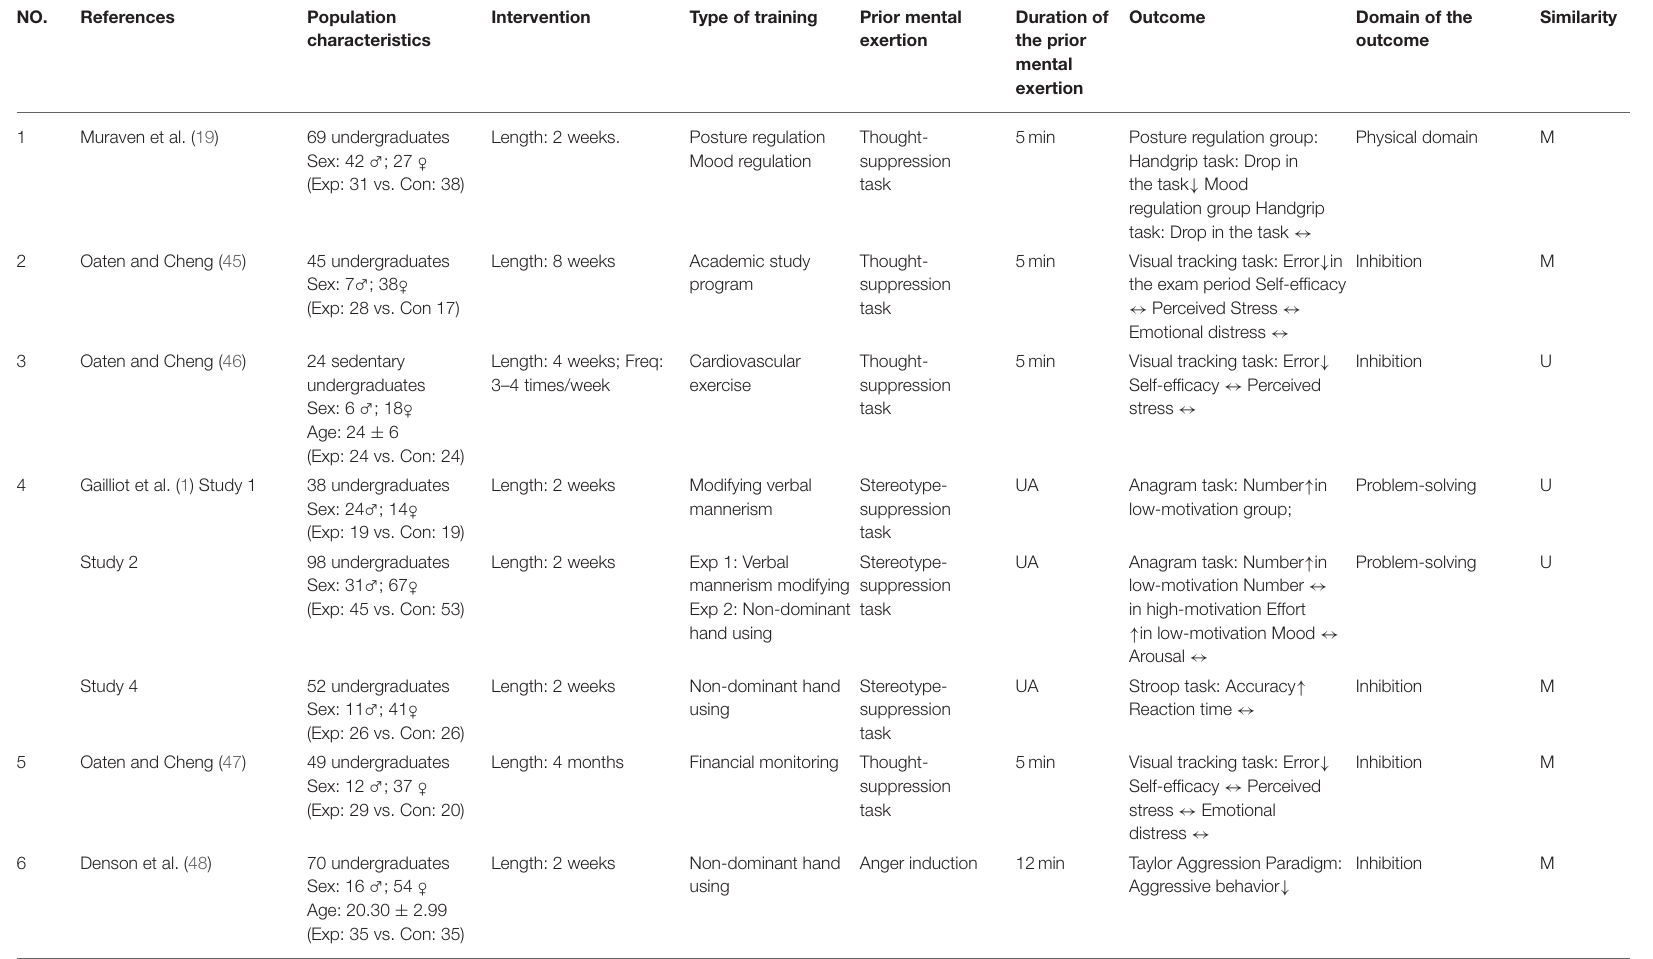
TABLE 2 | Overview of the included publications details.